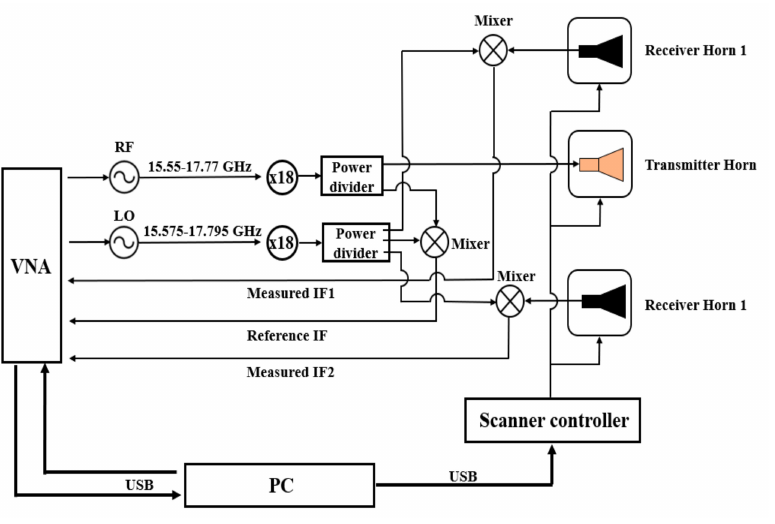
Figure 10. The schematic of experimental prototype.